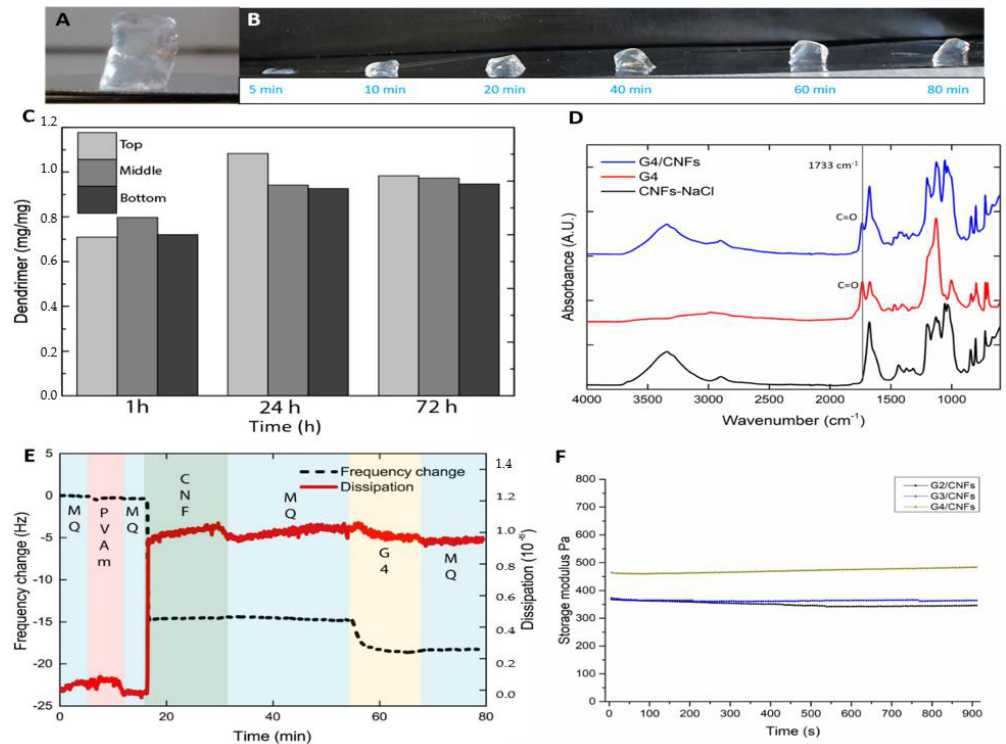
Figure 2. ( A ) Formation of the free-standing G4 / CNFs hydrogel. ( B ) Gelation propagation of the hybrid hydrogels with increasing interaction times. ( C ) Display of a homogeneous distribution of cationic dendrimers within the G4 / CNFs hydrogel as determined by elemental analysis of the nitrogen content. ( D ) FTIR spectra of G4, G4 / CNFs hydrogels and NaCl / CNFs. ( E ) Results from the Quartz Crystal Microbalance with Dissipation (QCM-D) measurements of the interaction of G4 with CNFs. ( F ) The storage moduli of the thin-film hydrogels of G2 / CNFs, G3 / CNFs and G4 / CNFs from the rheology evaluations.